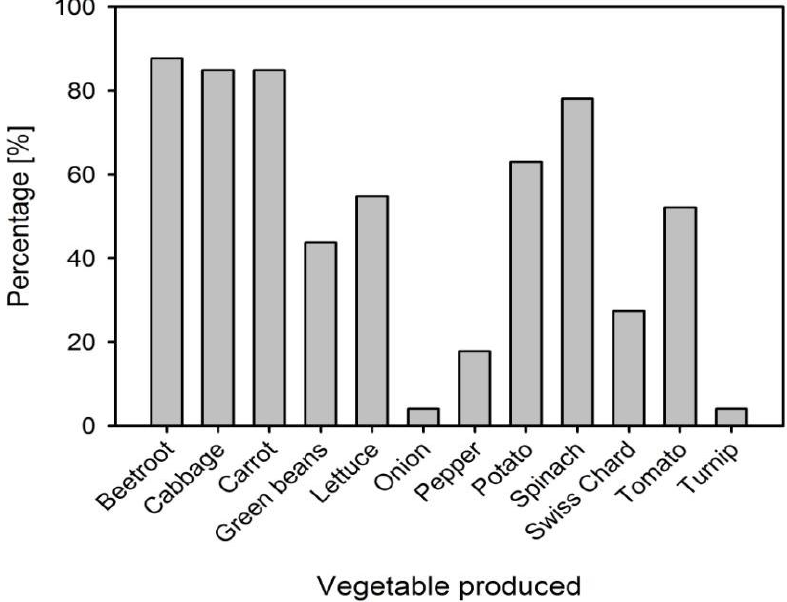
Figure 1. Most produced vegetables by farmers who participated in the survey (multiple vegetables per respondent, n =